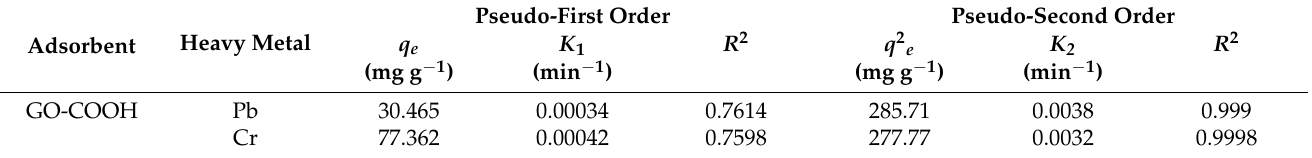
Table 2. Adsorption kinetics parameters for metals adsorption on GO-COOH.